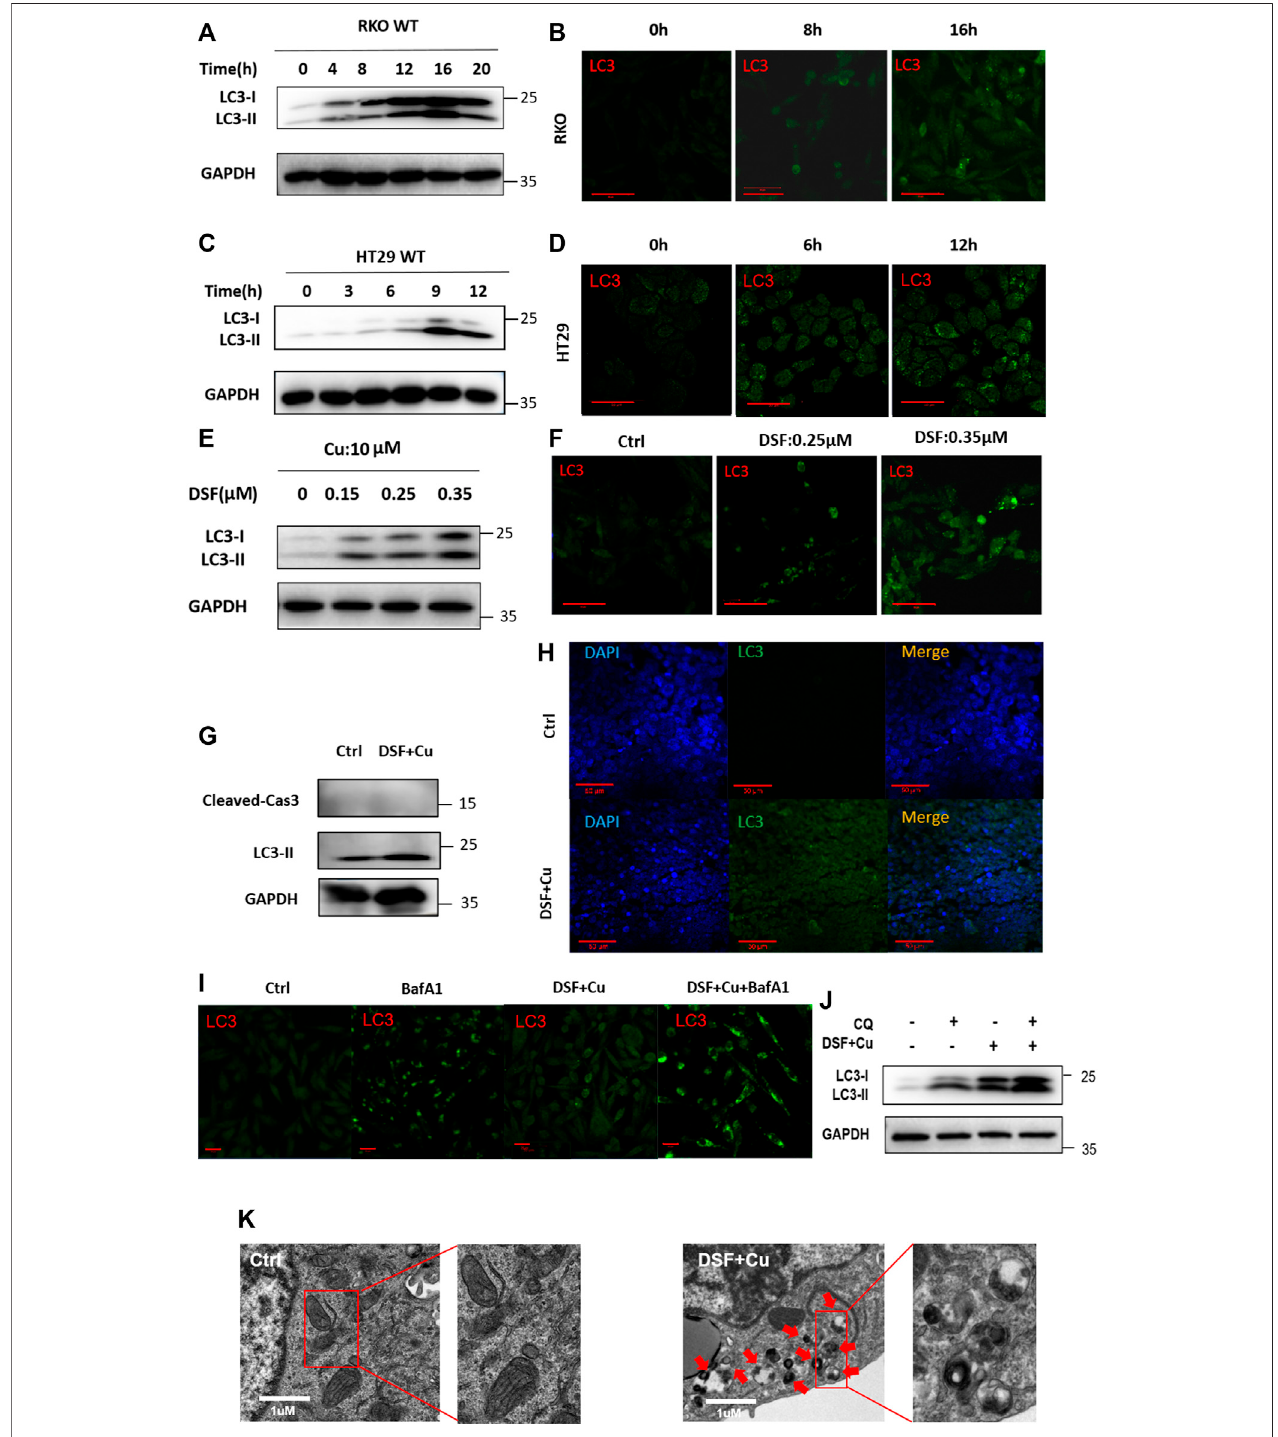
FIGURE4| DSF/Cuactivatesautophagy fl ux. (A,C) RKOandHT29cellstreatedwithDSF/Cu(0.25/10 μ M)for0 – 16 hwereanalyzedbyWesternblot. (B,D) RKO and HT29 were treated with DSF/Cu (0.25/10 μ M) for 0 – 16 h. The distribution of LC3 was examined by immuno fl uorescence. (E – F) The expression of LC3II was detectedbyWesternblottingandimmuno fl uorescenceinRKOafterincubationwithdifferentconcentrationsofDSF(0 – 0.35 μ M)and fi xedCu(10 μ M)for12 h (G,H) The expression of LC3 was detected by Western blotting and immuno fl uorescence in xenografts. (I) The expression of LC3 was detected by immuno fl uorescence in RKO treating withDSF/Cu (0.25/10 μ M)for12 hinthepresence orabsenceofBafA1 (0.5 μ M). (J) Theexpression ofLC3wasdetected byWestern blotinRKO treating with DSF/Cu (0.25/10 μ M) for 12 h in the presence or absence of CQ (5 μ M). (K) Representative images of autophagosome in RKO after incubation with DSF/Cu (0.25/ 10 μ M) for 36 h. The red arrow indicates autophagosome structure. Scale bars: 1 μ m.